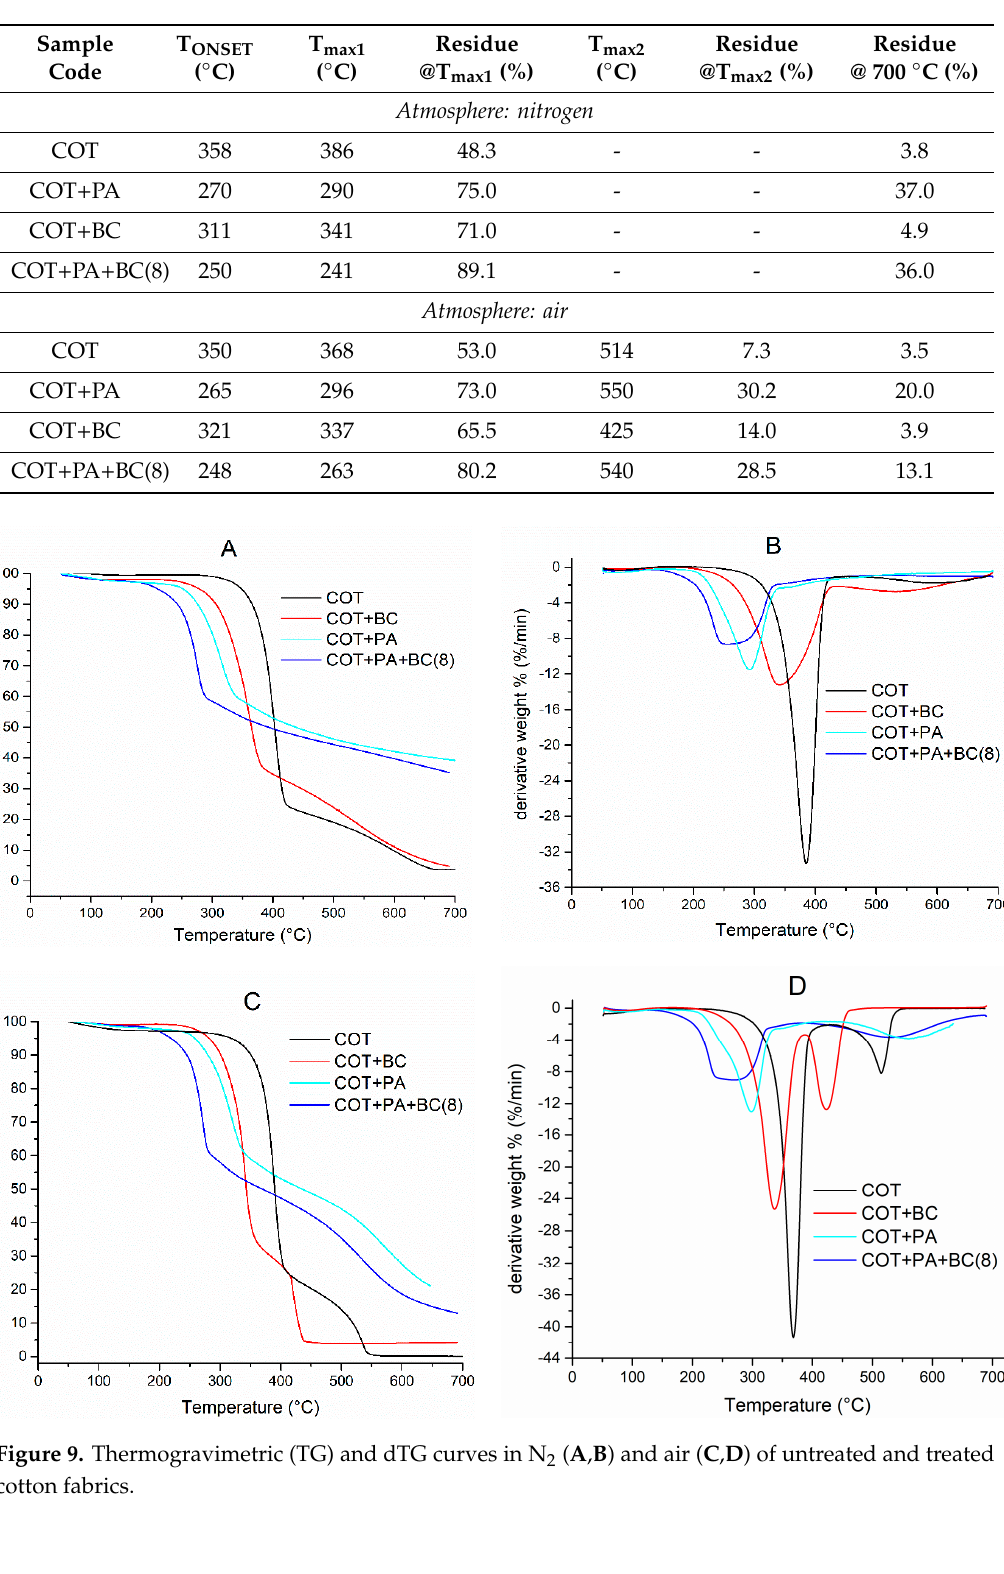
Table 5. Results from thermogravimetric analyses in nitrogen and air for cotton and for the treated fabrics.